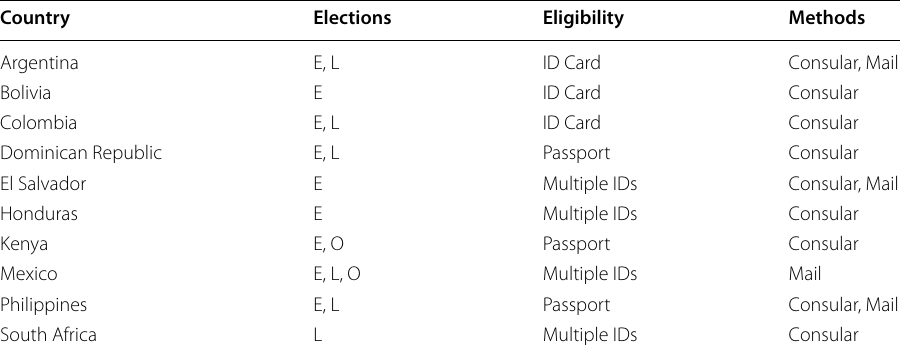
Table 2 Election types, voter eligibility and voting method for extraterritorial voting in violent